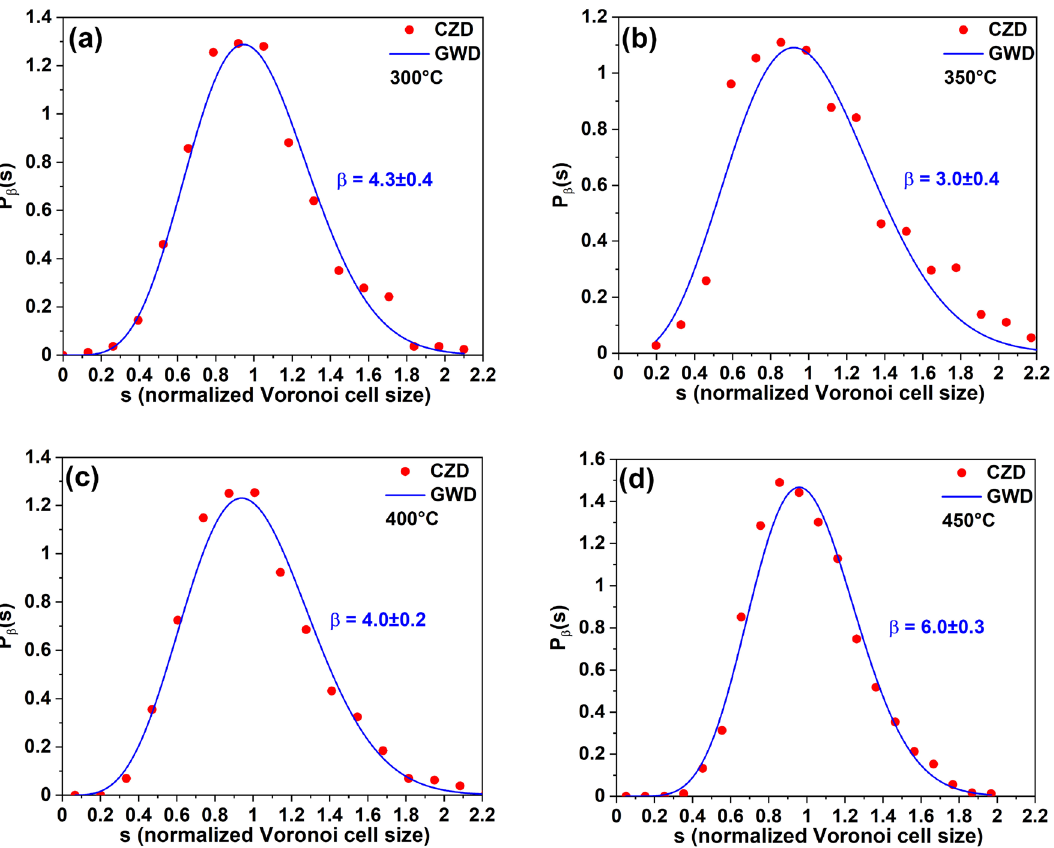
Figure 3. CZDs of the samples (a) T1, (b) T2, (c) T3, and (d) T4, fitted by the GWD. Sample